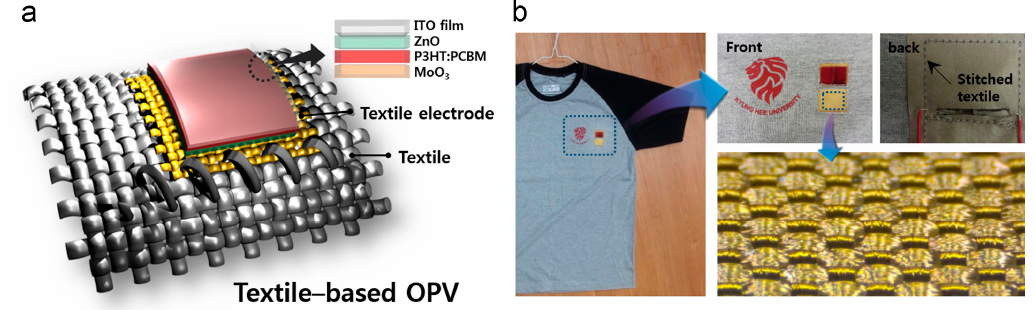
Figure 5. A textile based OPV developed by Lee et al. Reprinted from [105] with permission from Elsevier. ( a ) Schematic illustration of the textile OPV. ( b ) Photographs of the textile OPV integrated with clothing.